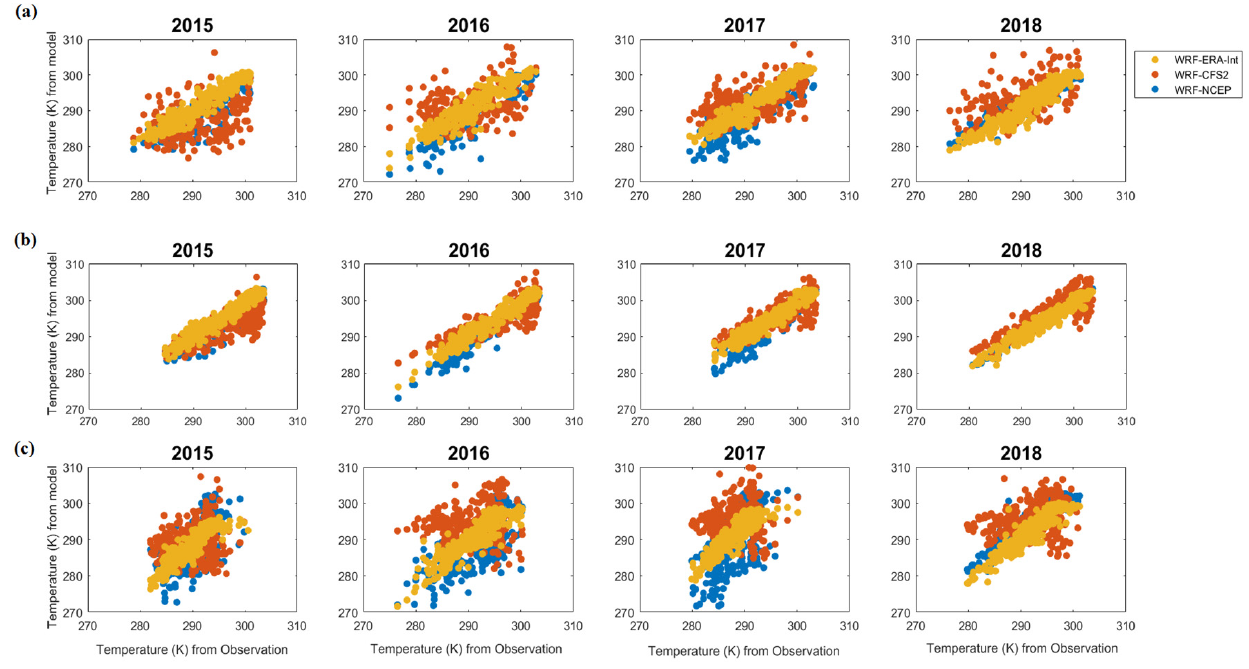
Figure A11. Daily average temperature in K from the models and observations at the offshore locations ( a ) Quanzhou, ( b ) Shanwei, and ( c ) Nansan.